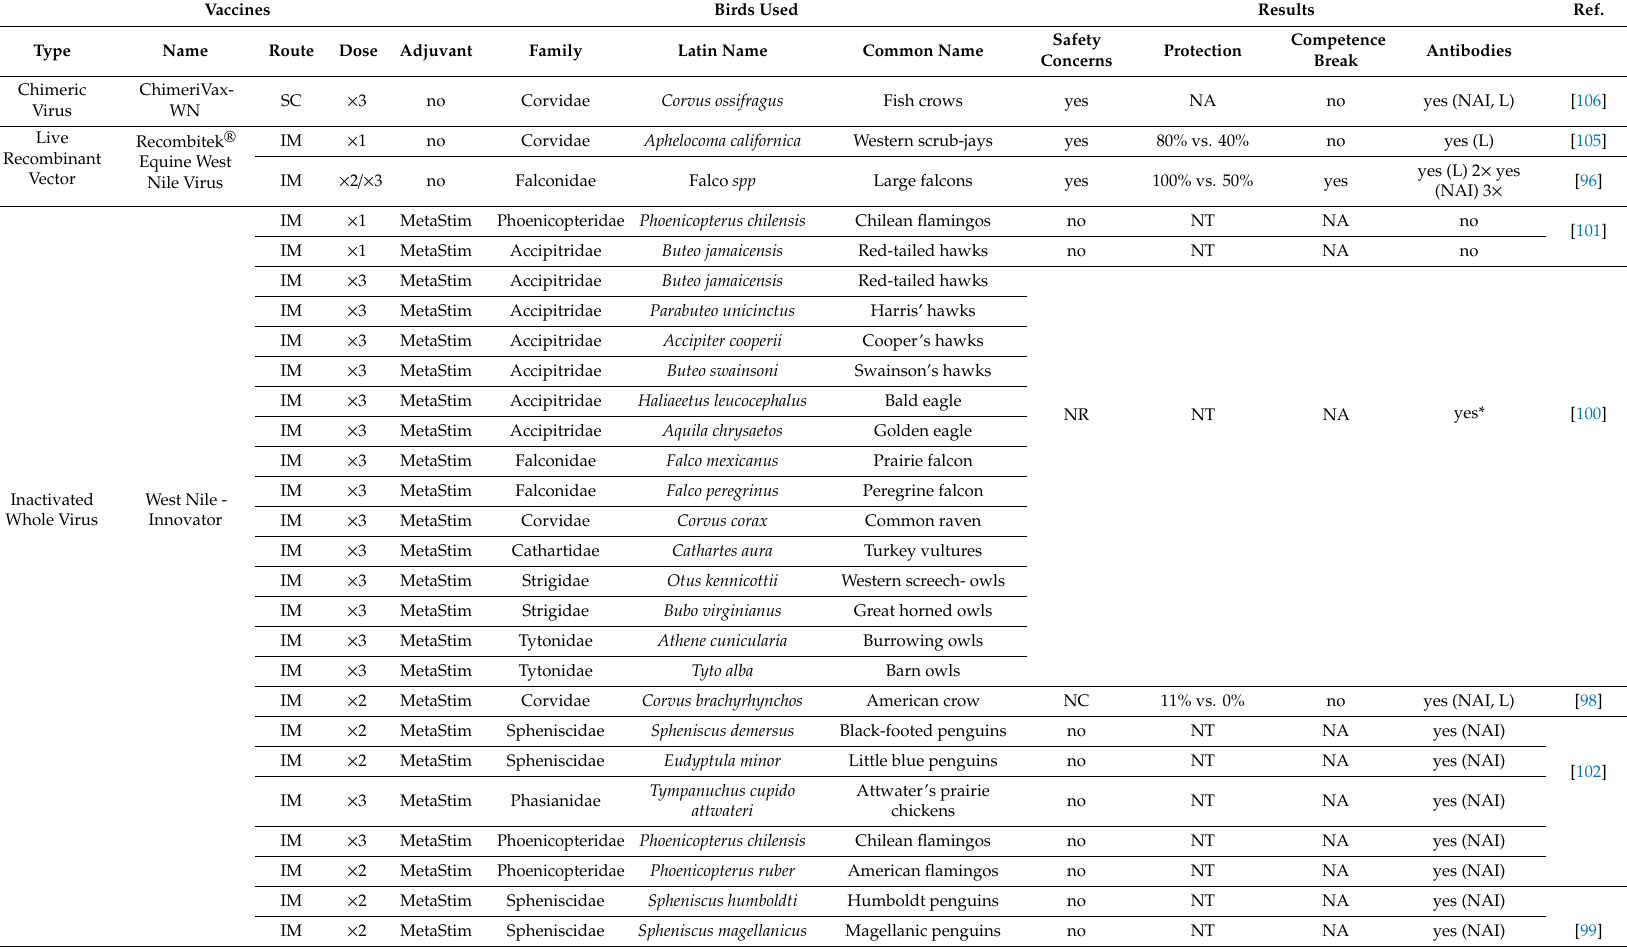
Table 1. Vaccines tested in wild